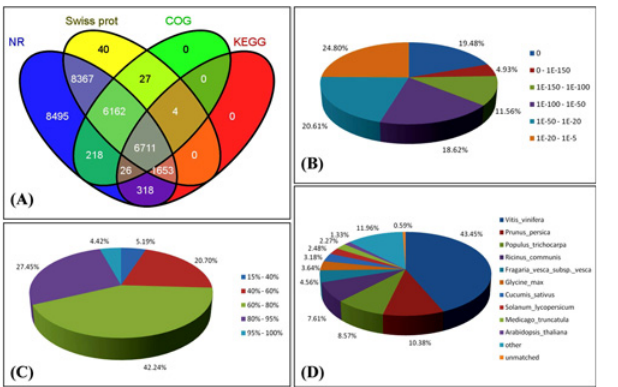
Fig 4. Characteristics of homology search of ‘ Hangbaishao ’ unigenes against the NR database. (A) Venn diagram of number of unigenes annotated by BLASTx with an E-value threshold of 10 -5 against protein databases. The numbers in the circles indicate the number of unigenes annotated by single or multiple databases. (B) E-value distribution of the top BLASTx hits for each unigene. (C) Similarity distribution of the top BLASTx hits for each unigene. (D) Species distribution of the top BLASTx hits for all homologous sequences.